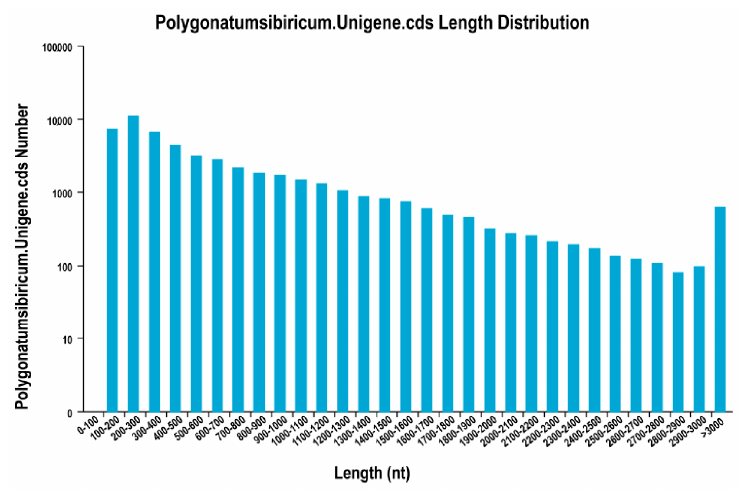
Figure 4. Distribution of lengths for coding sequences (CDSs) predicted from Polygonatum sibiricum unigenes.